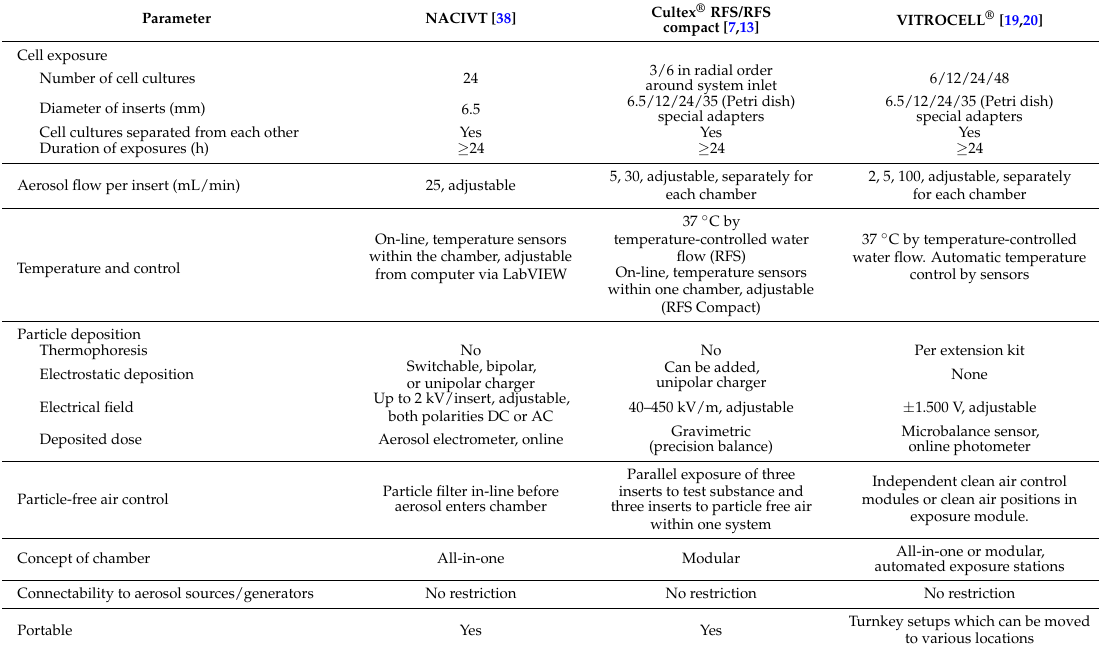
Table 2. Physical performance of NACIVT in comparison to other aerosol deposition chambers for exposures of ALI cell cultures